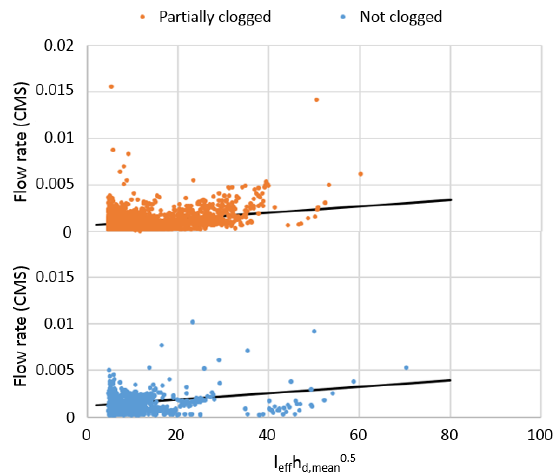
Figure 11. Performance plotted as flow rate vs. ℎ 𝑑,𝑚𝑒𝑎𝑛 𝑙 𝑒𝑓𝑓 for all data with 5-min rainfall depth <0.65 mm.